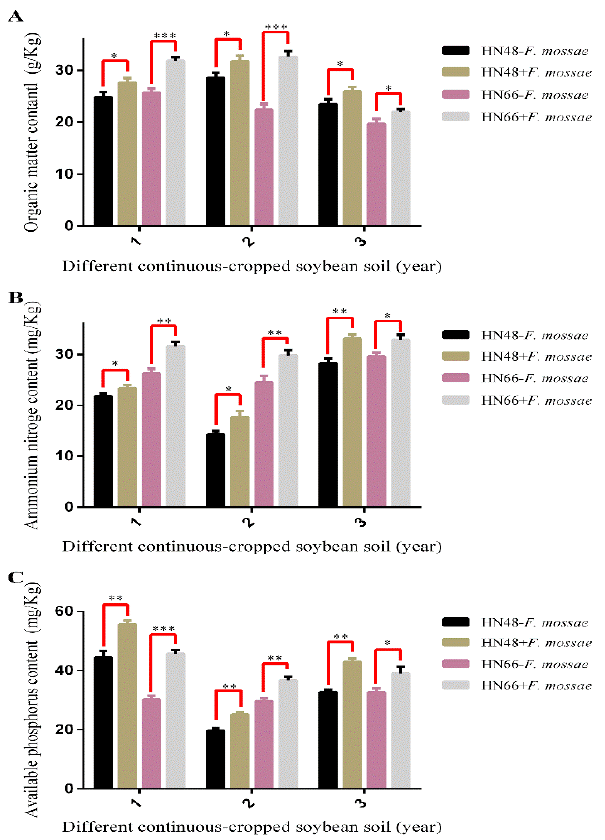
Figure 5. The physicochemical properties of two soybean cultivars rhizosphere soil under different continuous-cropped year soil in potted-experiments of soybean: 1 means soybean were planted the normal soil; 2 means soybean were planted in one-year continuous cropping soybean soil; and 3 means soybean were planted in three-year continuous cropping soybean soil. Each value represents the average of six independent experiments and the error bars represent standard deviations. Asterisks indicate the significance of differences between the samples. p values were calculated by Student’s t -test. Single asterisk indicates p < 0.05; double asterisks indicate p < 0.01; Triple asterisks indicate p < 0.001.